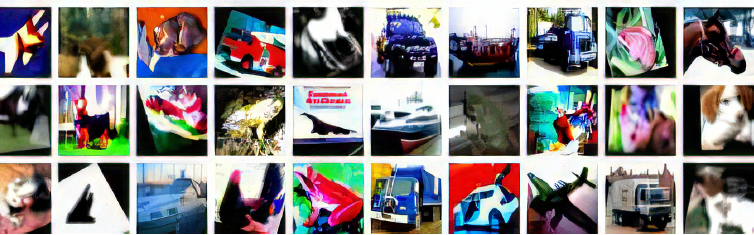
Figure 2. The transformed image in the meta-dataset. The source images are from the training set. These images have the same label as the source